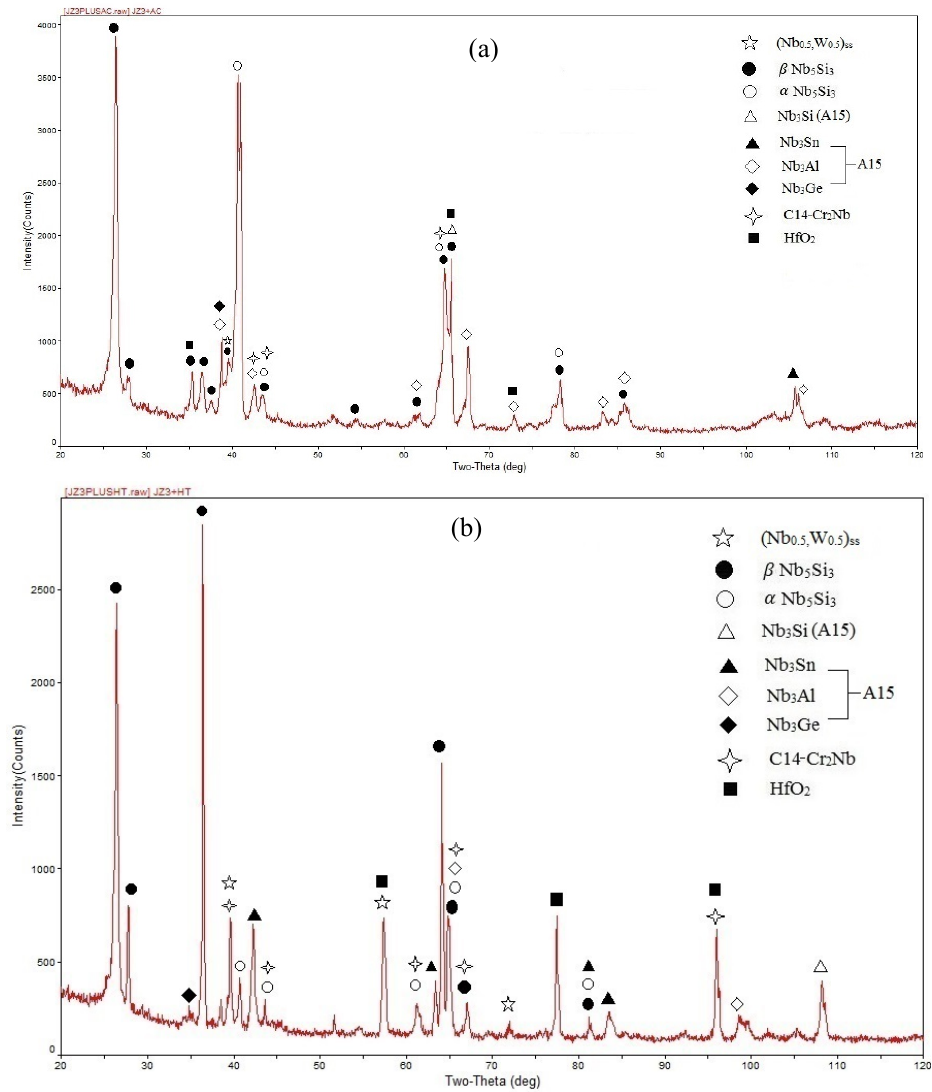
ff ractograms of the alloy JZ3 + . ( a ) AC and ( b ) Figure 2. The X-ray diffractograms of the alloy JZ3+. ( a ) AC and ( b ) HT. Figure 2. The X-ray di